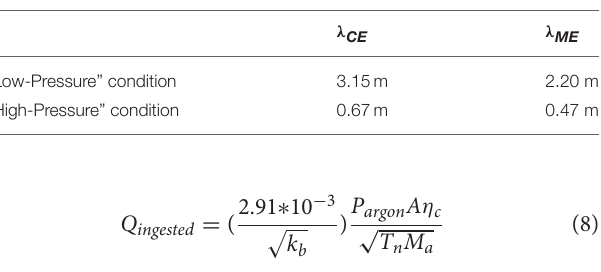
TABLE 2 | Mean free path lengths for charge-exchange ( λ CE ) and momentum-exchange ( λ ME ) collisions for the “Low-Pressure” and “High-Pressure” conditions.